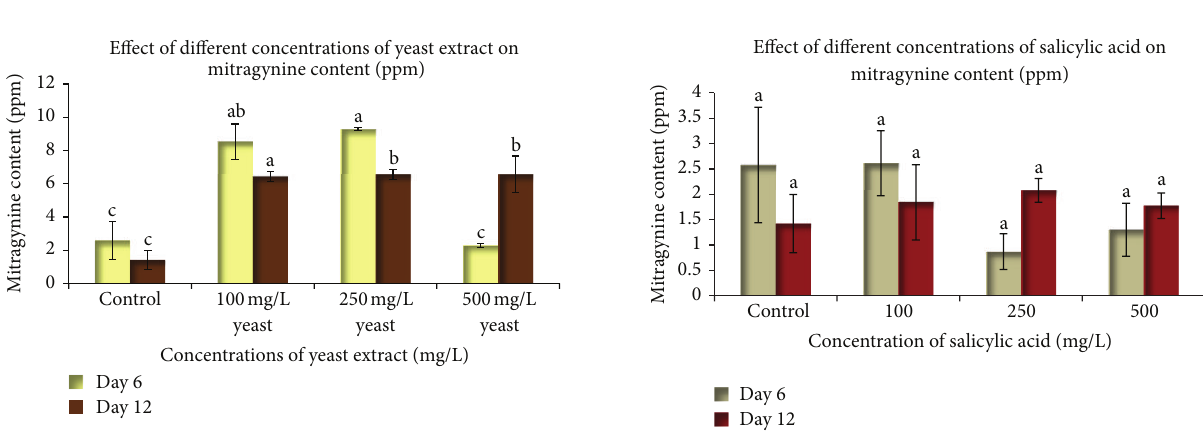
Figure 6: The effect of different salicylic acid concentrations at different culturing times on the mitragynine content in the Mitrag- yna speciosa suspension culture. The bars indicate standard error. ∗ Valueswiththesamelettersarenotsignificantlydifferentaccording to Duncan’s multiple range